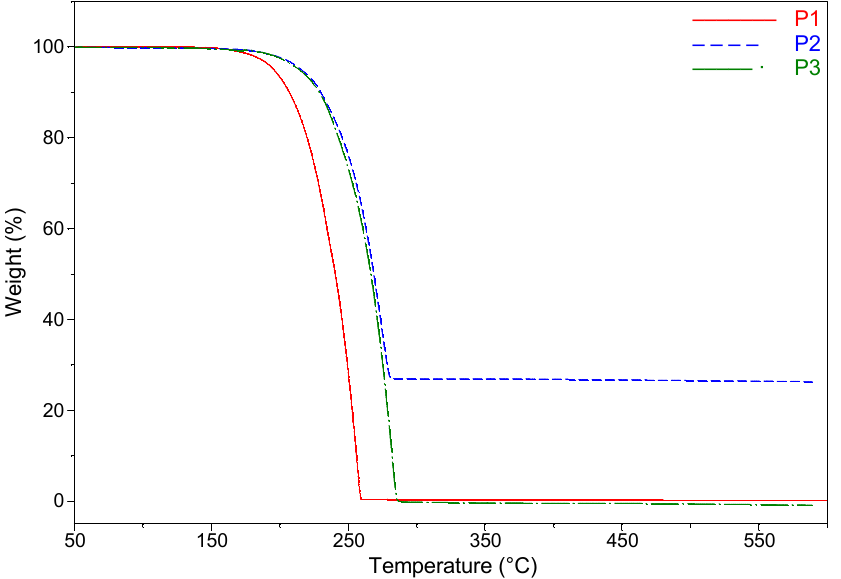
Figure 1. Thermogravimetric analysis curves of the studied pyrazoles.